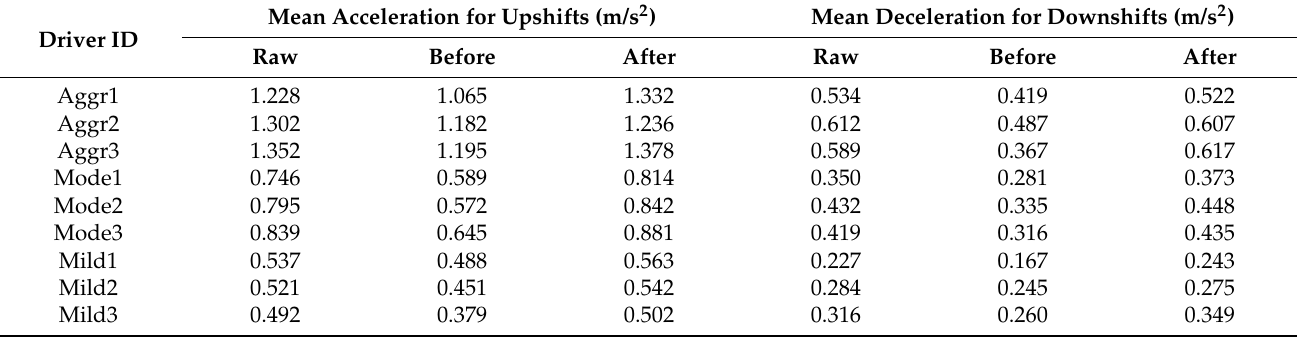
Figure 11. Gear counts and shifting performance of 12 drivers: Before VS after calibration. Table 5. Statistics of acceleration and deceleration among three styled drivers.